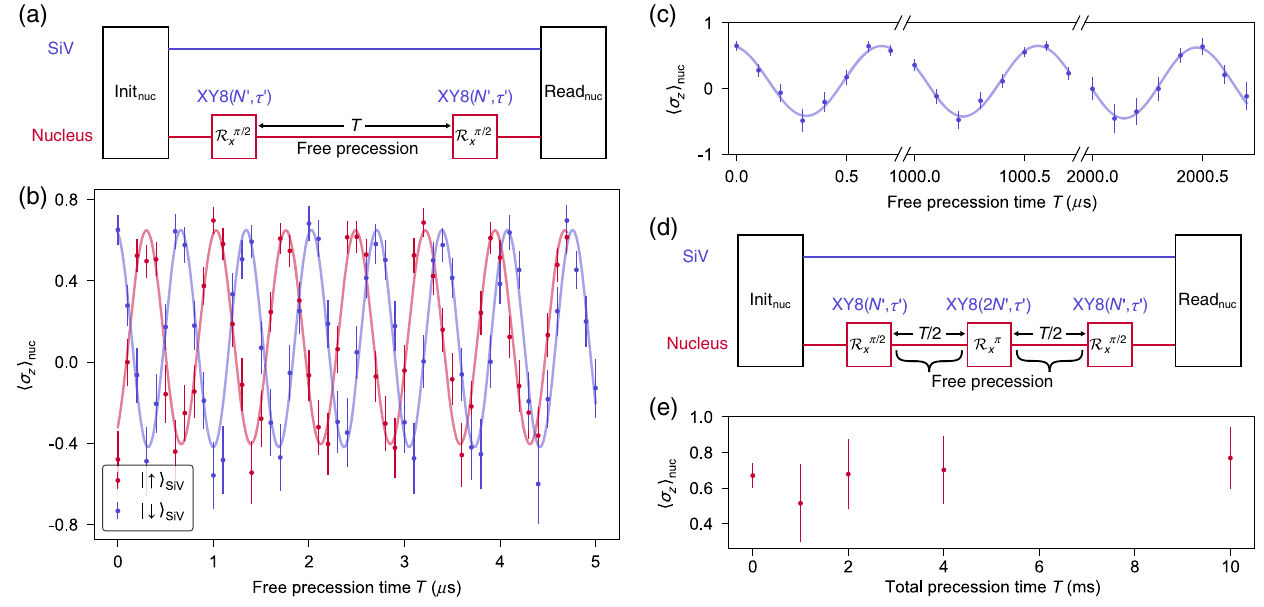
FIG. 4. Mechanically driven Ramsey interferometry and spin echo of the 13 C nuclear spin. (a) Sequence for Ramsey interferometry. Two ϕ 0 ¼ π = 2 rotations of the nuclear spin, corresponding to XY8 sequences with N 0 ¼ 8 and τ 0 ¼ 1 . 578 μ s, are separated by a free precession time T . (b) Mechanically driven Ramsey interferometry of the nuclear spin. The electron spin is initialized in j ↑ i ( j ↓ i ) after the first π = 2 nuclear rotation, corresponding to the red (blue) dots. The nuclear spin precesses at different rates depending on the state of the electron spin. The solid curves are sinusoidal fits, whose frequencies are consistent with the hyperfine coupling parameters determined earlier. (c) Ramsey oscillations measured at longer precession times. There is no decrease in the amplitude of the oscillations, indicating T (cid:3) 2 ≫ 2 ms for the 13 C nuclear spin. (d) Sequence for nuclear spin echo. The π rotation of the nuclear spin is implemented using an XY8 sequence with 2 N 0 ¼ 16 and τ 0 ¼ 1 . 578 μ s. (e) Spin-echo measurement showing no decay up to 10 ms, indicating T echo ≫ 10 ms for the 13 C nuclear 2